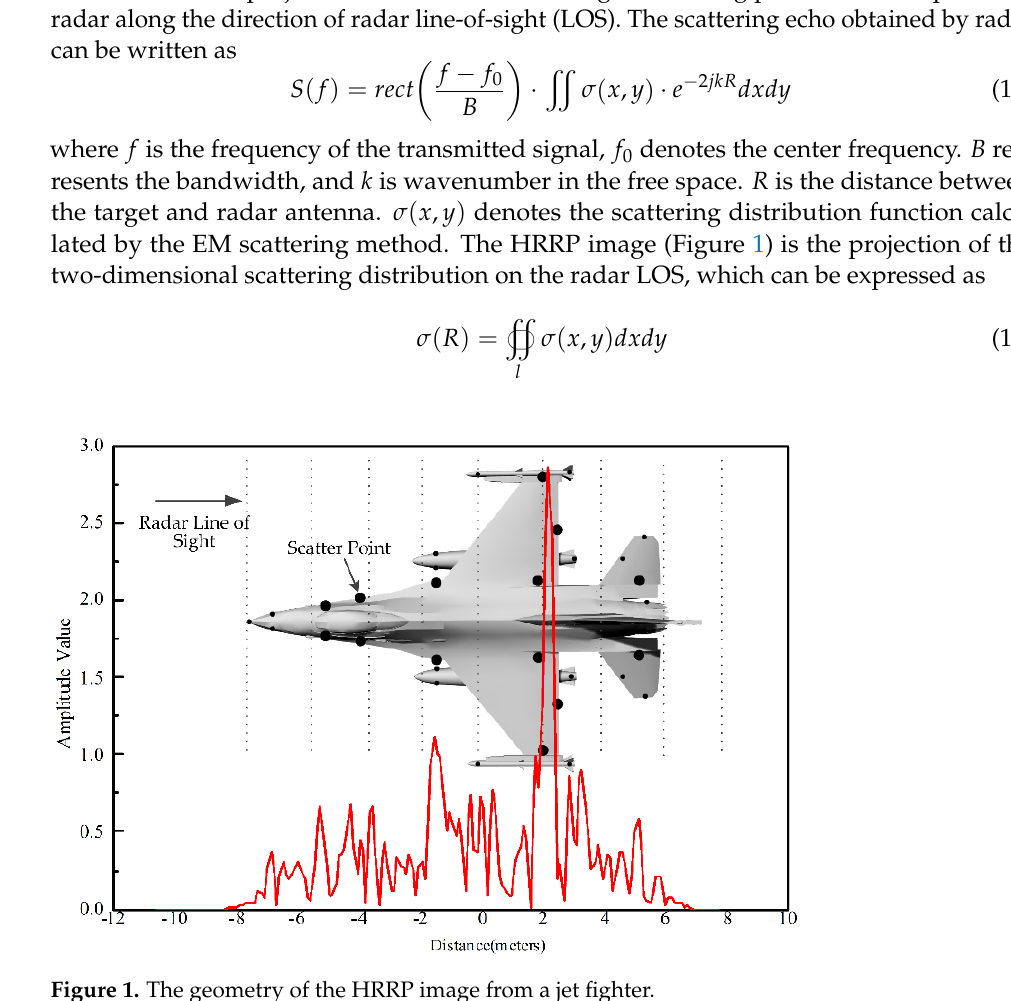
Figure 1. The geometry of the HRRP image from a jet fighter.